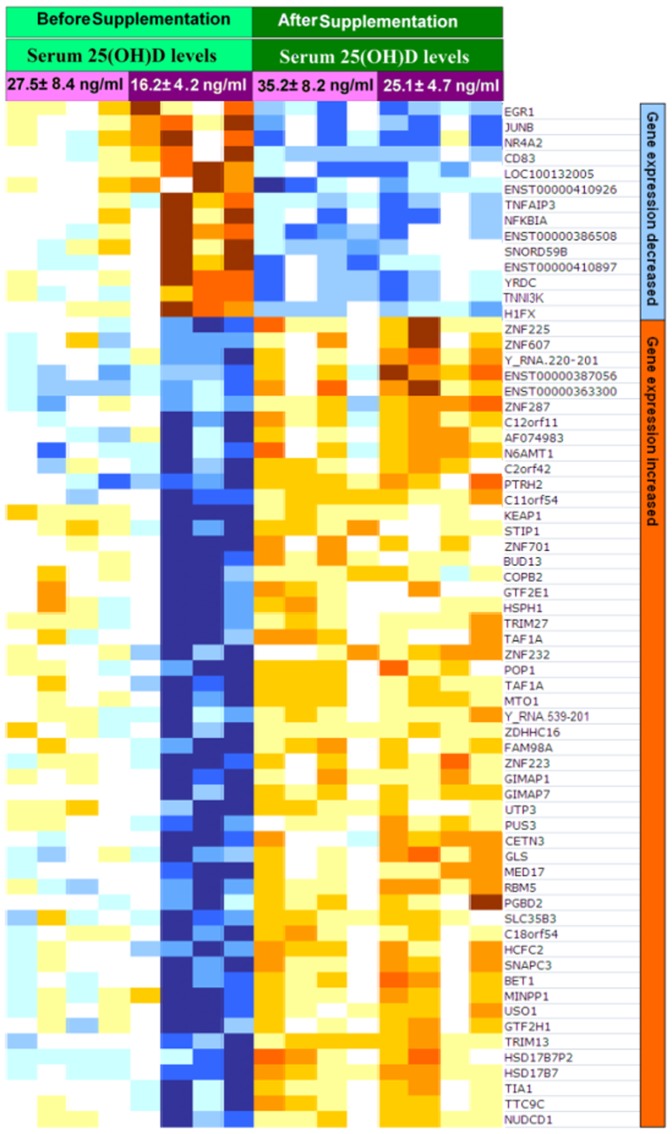
Heatmaps of vitamin D responsive genes affected by vitamin D status.Before supplementation (light green) four subjects were vitamin D deficient with 25(OH)D of 16.2±4.2 ng/ml (dark purple) and the other four subjects were insufficient or sufficient with a 25(OH)D of 27.5±8.4 ng/ml(light purple). After supplementation (dark green) serum levels of 25(OH)D in vitamin D insufficient/sufficient subjects increased to 35.2±8.2 ng/ml (light purple) and in the vitamin deficient subjects increased to 25(OH)D of 25.1±4.7 ng/ml(dark purple). Two groups of gene-expression changes are seen based on stimulation (brown) or inhibition (blue) of gene expression post vitamin D3 supplementation. (Colors ranged from blue to brown; High expression  =  brown, average expression  =  white, low expression  =  blue).Expression of 66 genes before supplementation was significantly different in the vitamin D deficient group (dark purple) compared to the vitamin D insufficient/sufficient group (light purple). Clustering of the 66 genes affected by vitamin D status and vitamin D3 supplementation was based on stimulation (brown) or inhibition (blue) of gene expression.